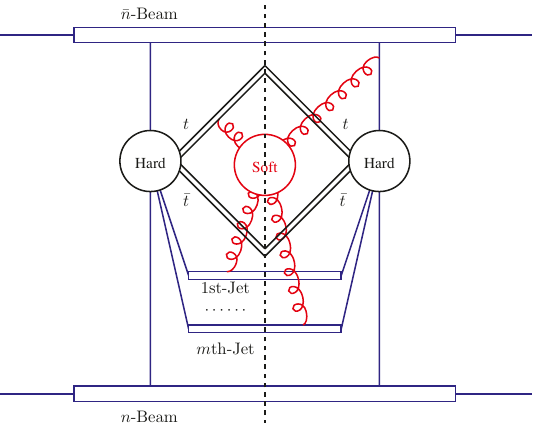
Figure 3 . Dynamic regions in the N J 1 configuration. Herein, the black bubbles stand for the ≥ hard modes. The red bubble and curly lines encode the soft corrections connecting the heavy partons represented by the black double lines as well as both the beam- and jet-collinear modes depicted in the blue straight